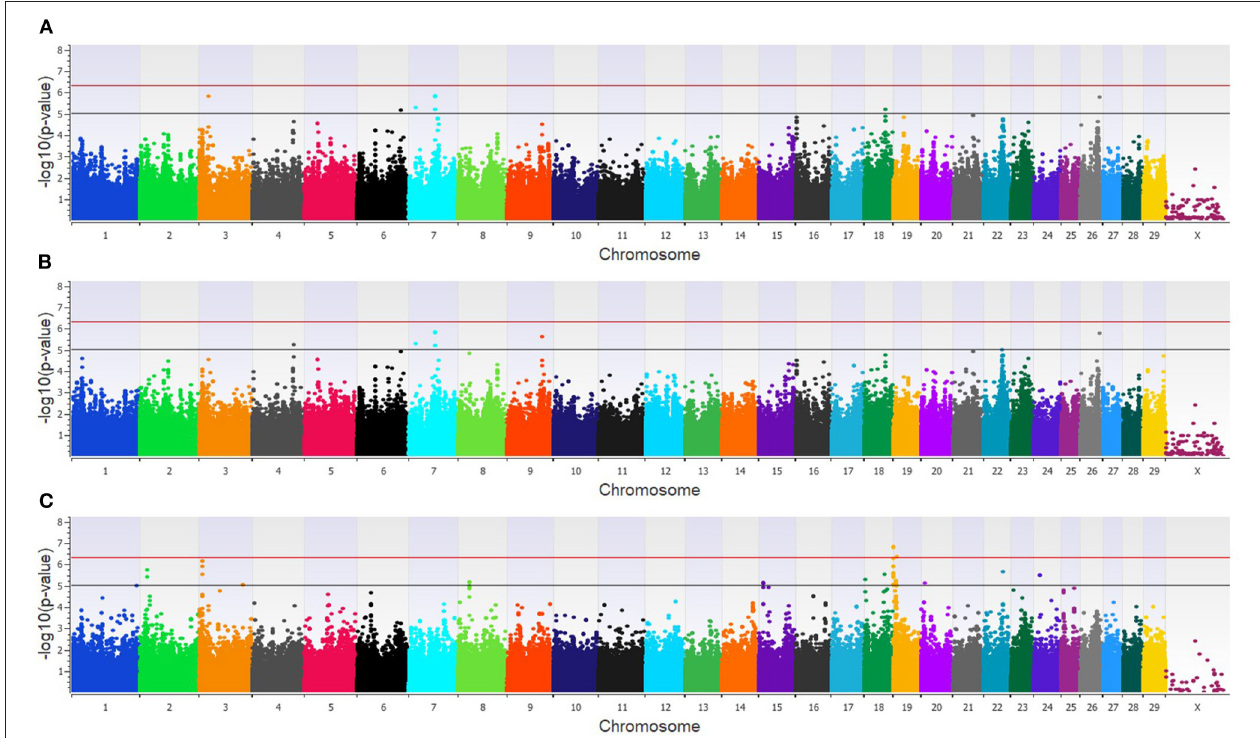
FIGURE 4 | Manhattan plots identifying loci associated with bovine coronavirus infection and bovine respiratory disease in additive (A) , dominant (B) , and recessive (C) EMMAX models for the dairy population. Single-nucleotide polymorphisms (SNP) are represented by a single dot. Bovine chromosomes are listed on the x-axis. SNPs located between the black and red lines provide evidence of moderate association ( p between 1 × 10 − 5 and 5 × 10 − 7 ), and SNPs above the red line provide evidence of a strong association ( p < 5 × 10 − 7 ) based on the Wellcome Trust Case Control Consortium ( 24)